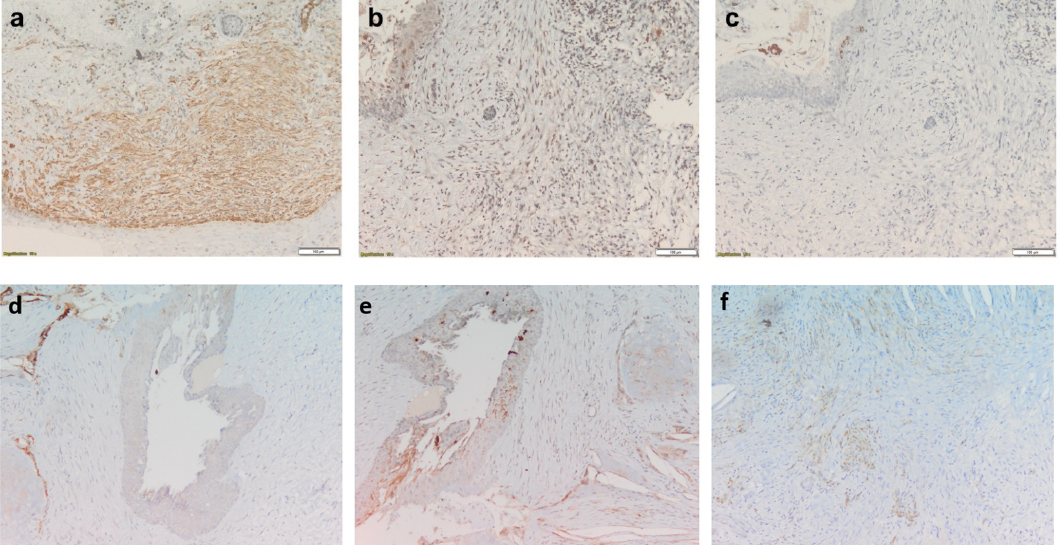
Figure 2. NBCCS-OKC, magnifications ×10. ( a ), α SMA markedly expressed in plump fibroblasts both in the epithelium and in the connective tissue, ×10; ( b ), MMP-7 moderately expressed in the MFs localized in the sub-epithelium and in the epithelial layer, ×10; ( c ), MMP-9 markedly detected in the endothelial cells and moderately in the sub-epithelial MFs, ×10; ( d ), Recurrent OKC, α SMA expression around the vessels, × 10; ( e ), Solitary OKC, MMP-7 expression in the inflammatory area and in the basal and intermediate connective wall, × 10; ( f ), Solitary OKC, MMP-9 slightly expressed in the basal-intermediate connective wall and moderately in the phlogosis areas, ×